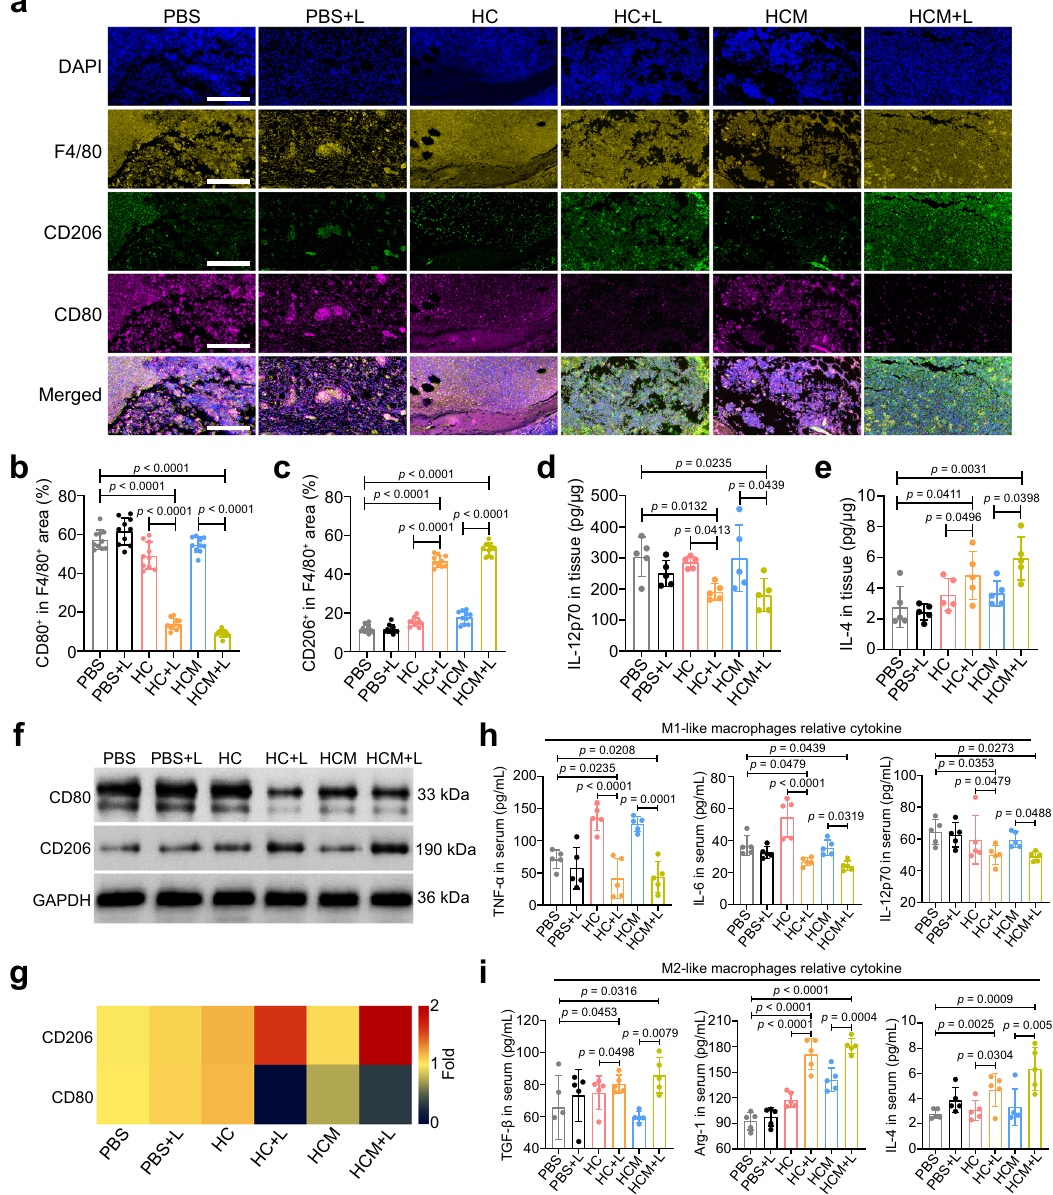
Fig. 6 Macrophage polarization of MRSA bio fi lm infected mice after PDT-activated chemotherapy. a Immuno fl uorescence images of F4/80 (yellow), CD206 (green), and CD80 (violet) in the infected tissues after treatment. Scale bar is 400 μ m. Percentage of CD80 + ( b ) and CD206 + ( c ) area to total F4/80 + area calculated from the immuno fl uorescence images ( n = 10 biologically independent samples; mean ± SD). Secretion levels of IL-12p70 ( d ) and IL-4 ( e ) in the infected tissues after treatment ( n = 5 biologically independent samples; mean ± SD). f Expression levels of CD80 and CD206 in the infected tissues determined by western blotting after treatment. g Heat map of the relative expression of CD80 and CD206 in the infected tissues compared to the PBS group calculated from western blotting results. Secretion levels of M1 macrophage-relative cytokines ( h ) and M2 macrophage-relative cytokines ( i ) in the serums isolated from mice after treatment ( n = 5 biologically independent samples; mean ± SD). All statistical signi fi cance was analyzed via one-way ANOVA with a Tukey post-hoc test. Source data are provided as a Source Data fi